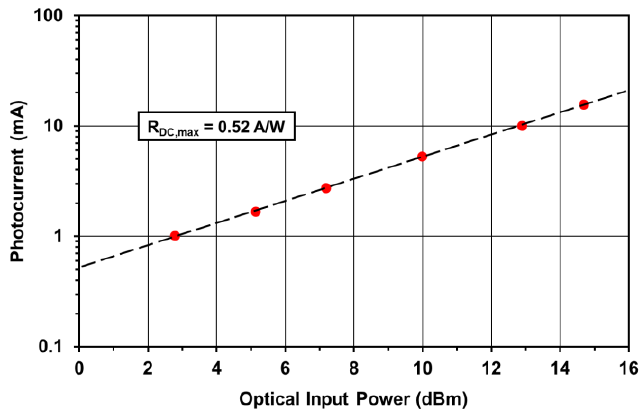
Figure 7. Measured photocurrent versus the optical input power for the operational wavelength of 1.55 µm at a bias voltage of −8 V. The dashed line shows the simulated photocurrent for the DC responsivity of 0.52